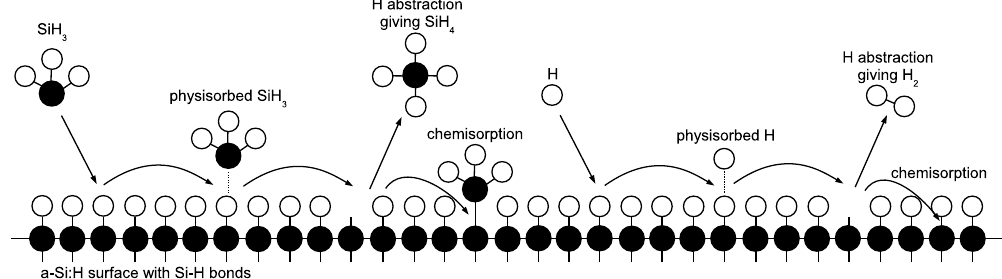
Figure 7. Chemical model illustration showing particle-surface